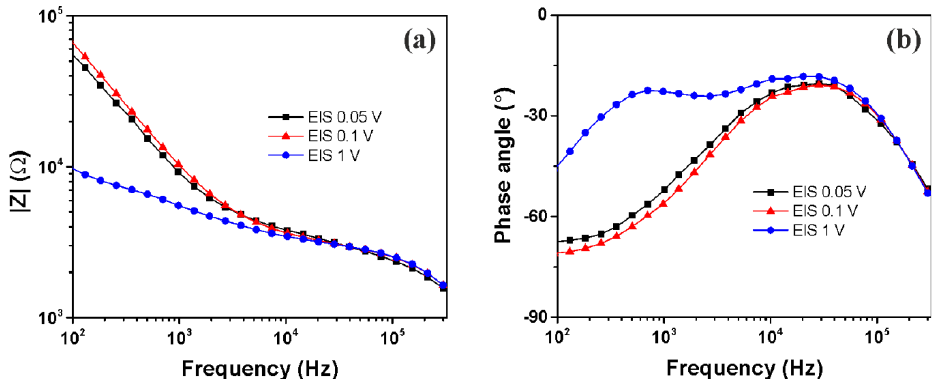
Figure 3. Impedance magnitude ( a ) and phase angle ( b ) of trapped HT-29 cells at various EIS operating voltages.